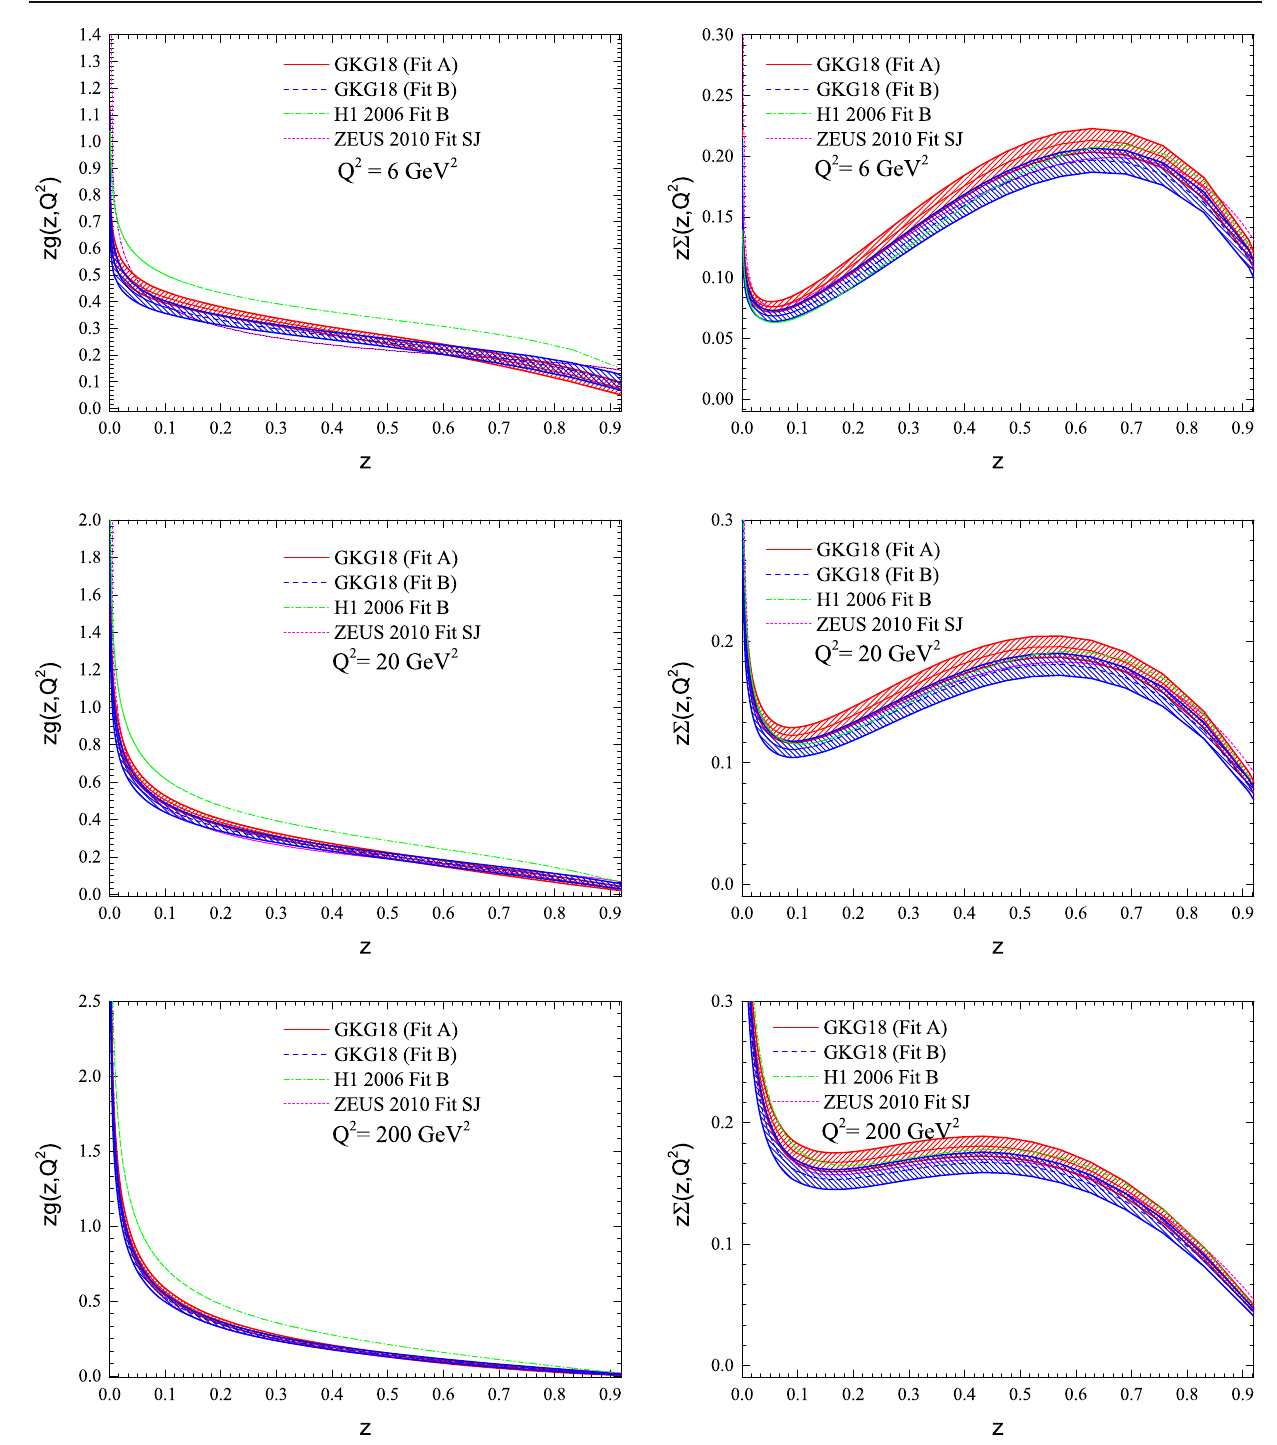
Fig. 5 (Color online) The total quark singlet z (cid:12)( z , Q 2 ) (right) and gluon zg ( z , Q 2 ) (left) distributions obtained from our NLO QCD fits at selected Q 2 value of Q 2 = 6 , 20 and 200 GeV 2 . The error bands correspond to the fit uncertainties